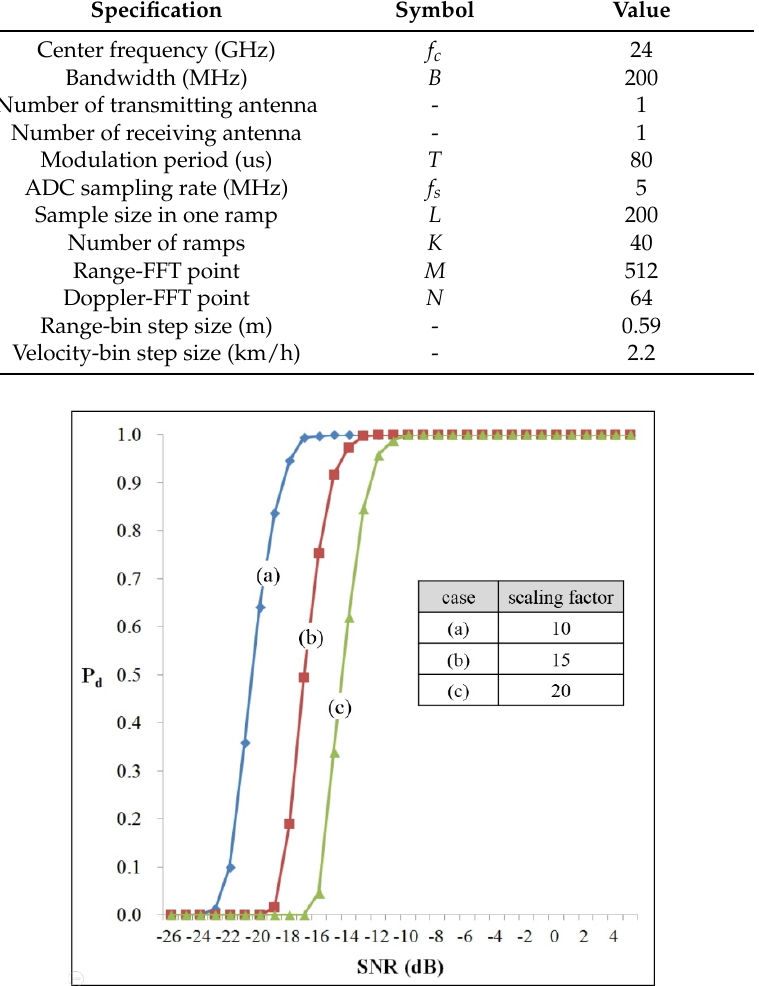
Figure 4. The detection probability of a moving target when varying the scaling factor for the SNR.